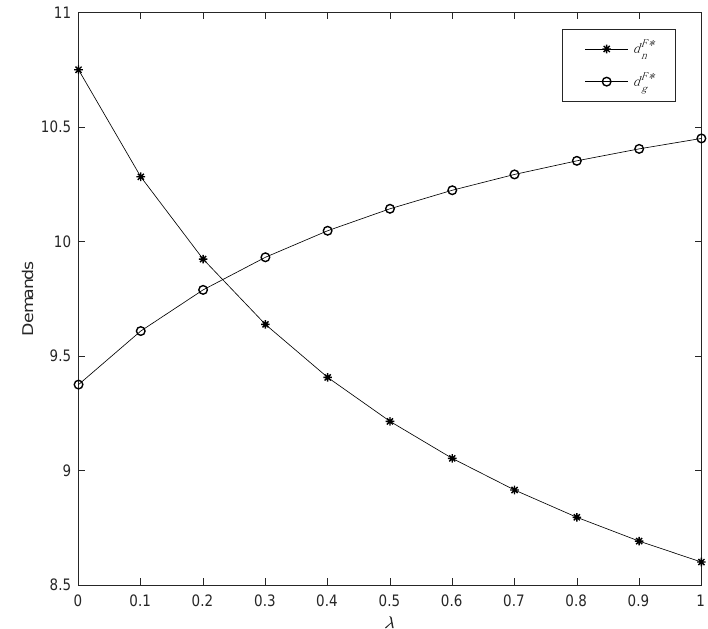
Figure 5. The change in demands with parameter λ.